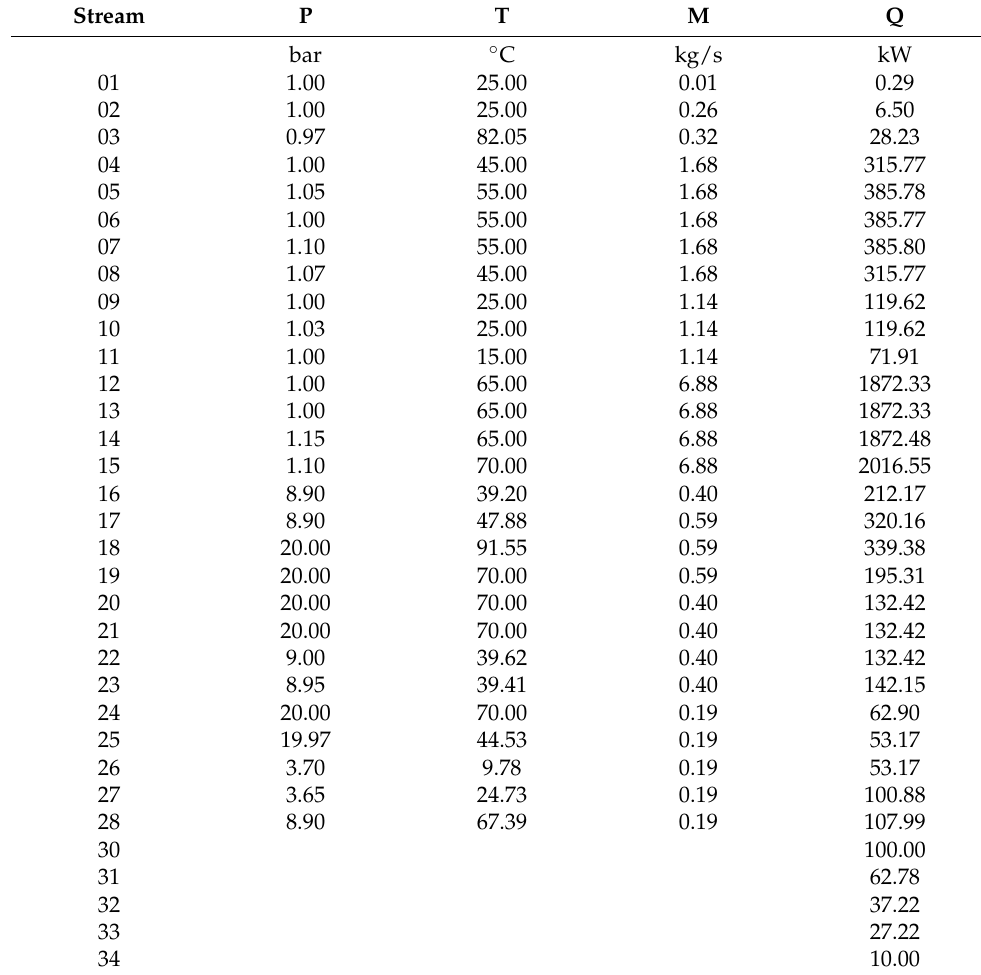
Table A3. Stream data of case C.